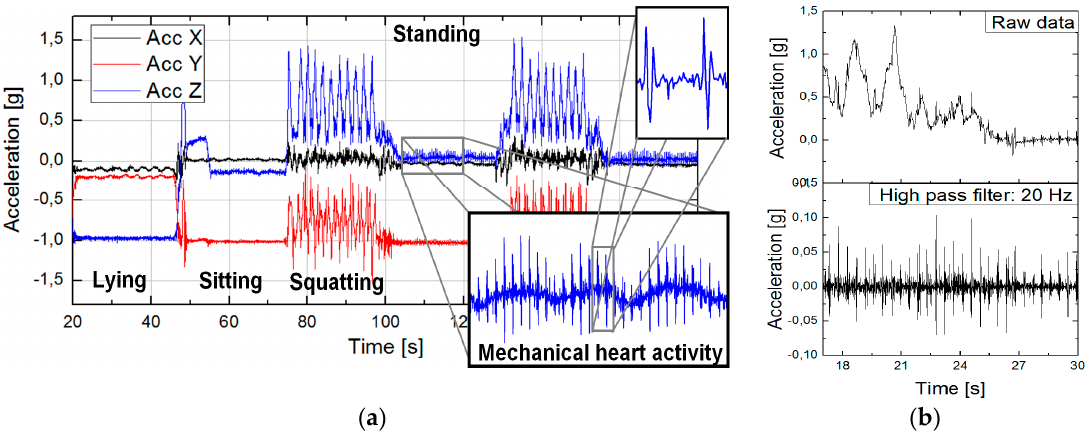
Figure 3. Holter inertial measurement units (IMU): ( a ) Body movement and seismocardiography (SCG), ( b ) heart rate (HR) during high physical activity.